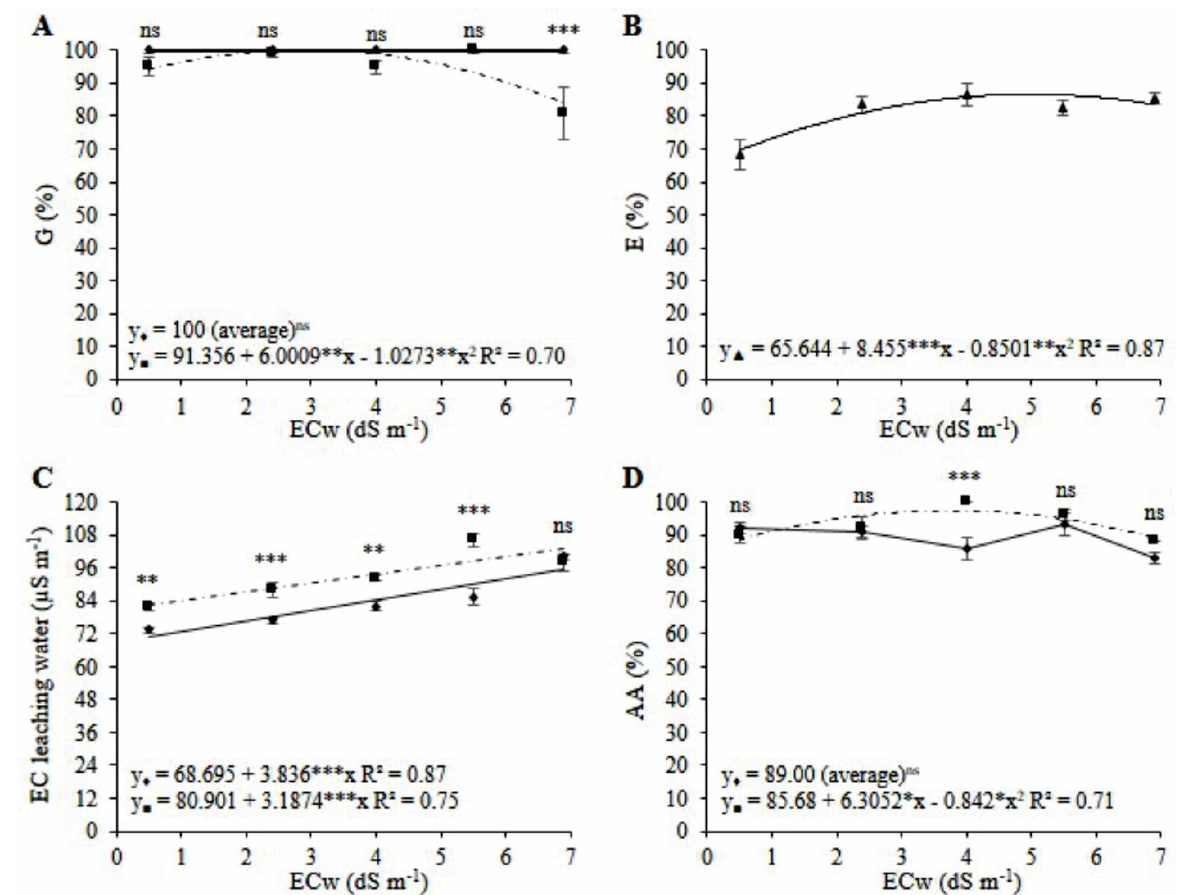
Figure 5. Regression analysis and means comparison test (Tukey, p < 0.05 and SD, n = 4) for the variables germination—G ( A ), emergence—E ( B ), electrical conductivity test—EC leaching water ( C ), and accelerated aging—AA ( D ) of seeds of mini watermelon in hydroponic cultivation using a nutrient solution prepared with reject brine and different substrates ( (cid:7) Coconut fiber; (cid:4) Sand). ***, **, *, and ns significant at 0.001, 0.01, 0.05 probability levels, and not significant,